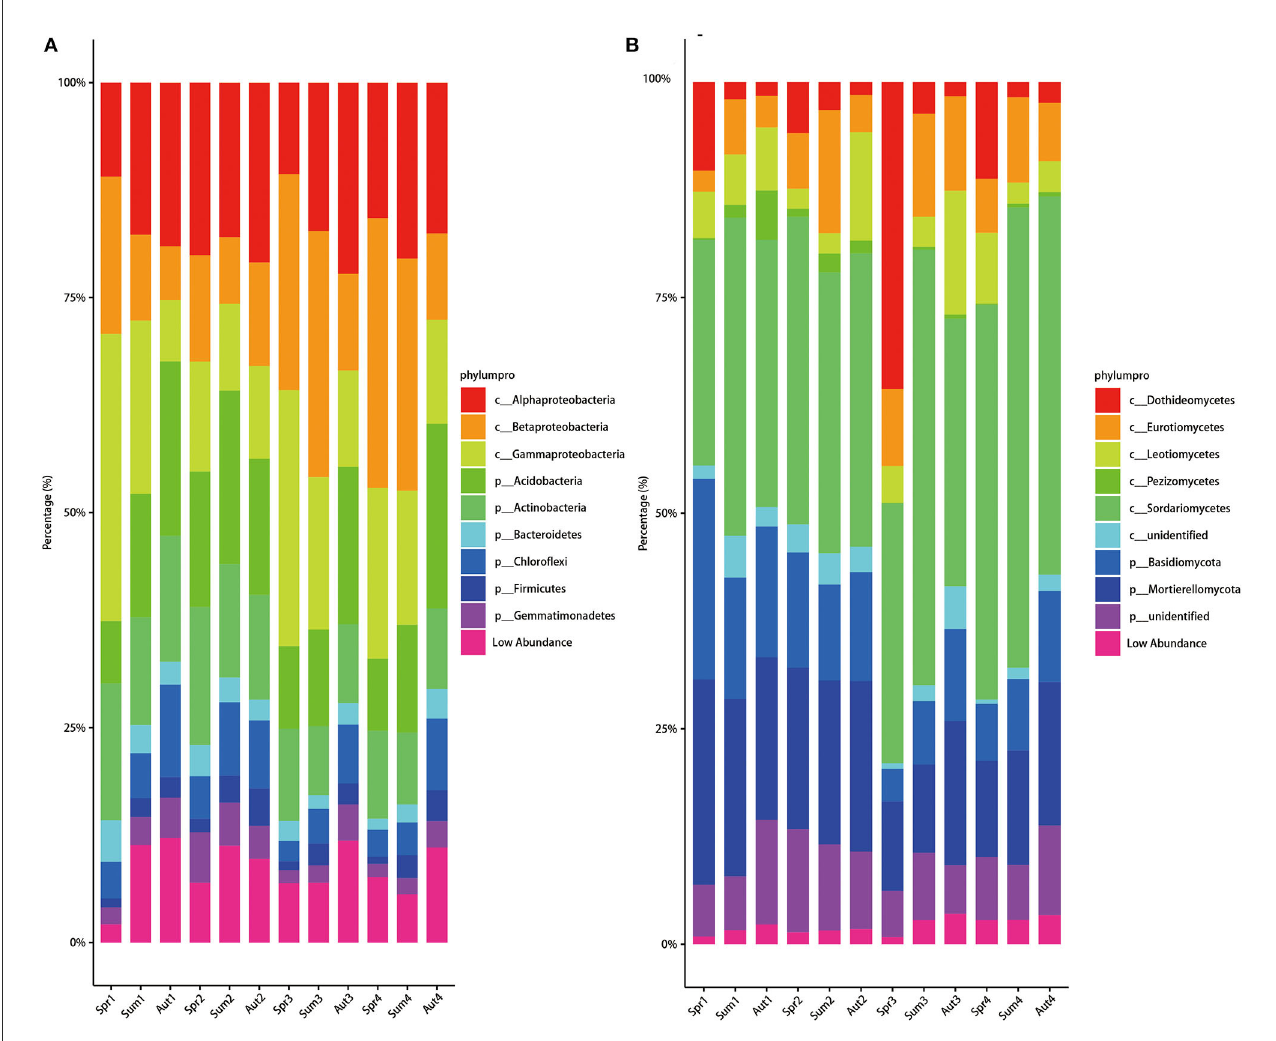
FIGURE4 Average relative abundances change over time of bacterial phylum (A) and fungal class (B) . Alluvial figures were plotted based on 80 samples of the two